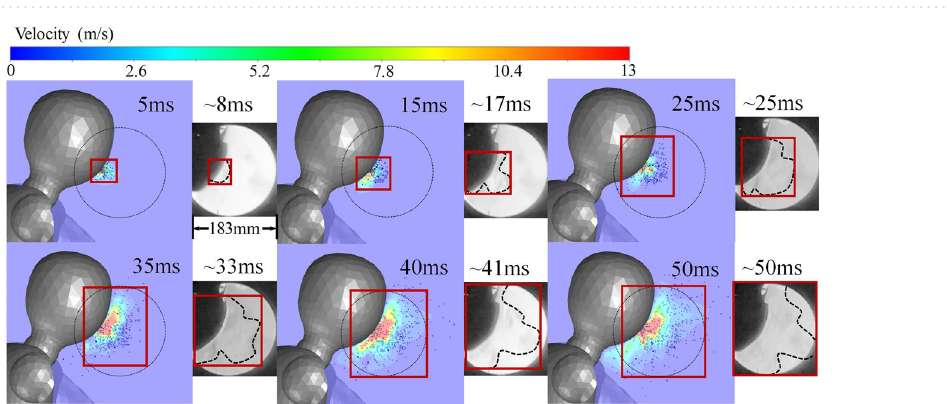
Figure 16. Typical cough without from CFD and Schlieren experiment. The figure was processed by Ansys Fluent (version 2019 R2) and drawn in Adobe Illustrator (version 16.0).